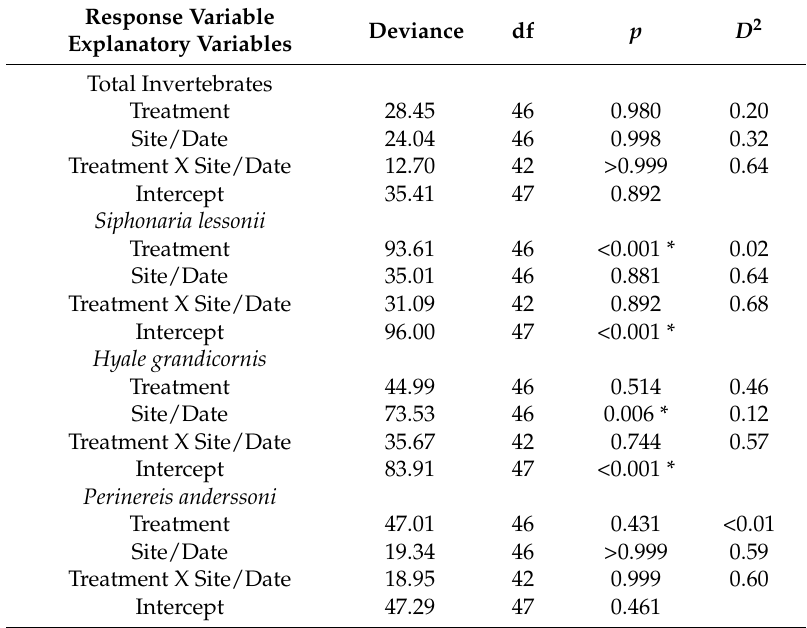
Table 5. Analysis of deviance for generalized linear models relating invertebrate counts (total invertebrates and three common species) with Treatment ( Porphyra removal vs. Controls) and experimental Sites/Dates (Punta Cantera/2011, Las Brusquitas/2015, and Copacabana/2017). Models. were fit using a negative binomial distribution and log link function. Significant deviance values (Chi-squared test, p < 0.05, see asterisks) indicate lack of effect of explanatory variables or their interaction on the dependent variable. D 2 is the proportion between the deviance explained by the model in question and the deviance of null, intercept